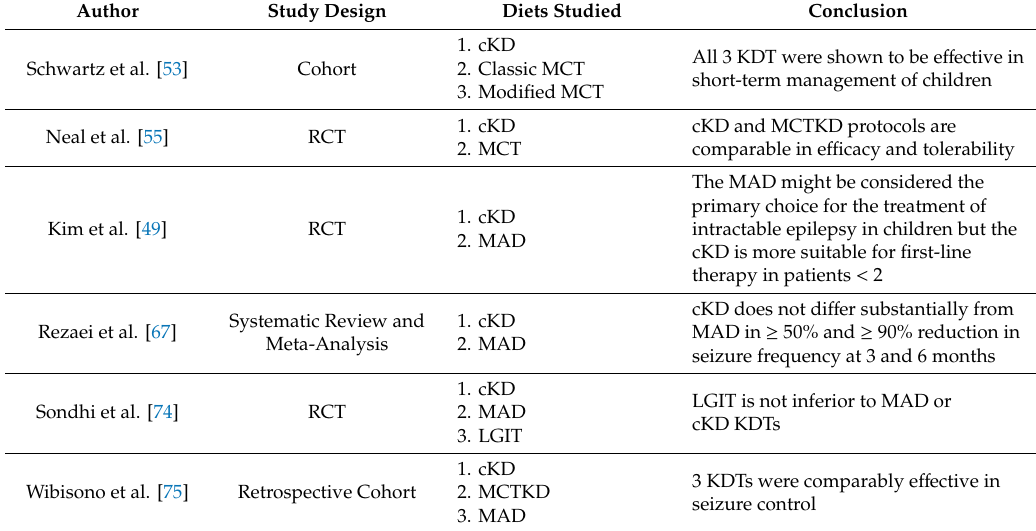
Table 2. E ffi cacy Comparisons of